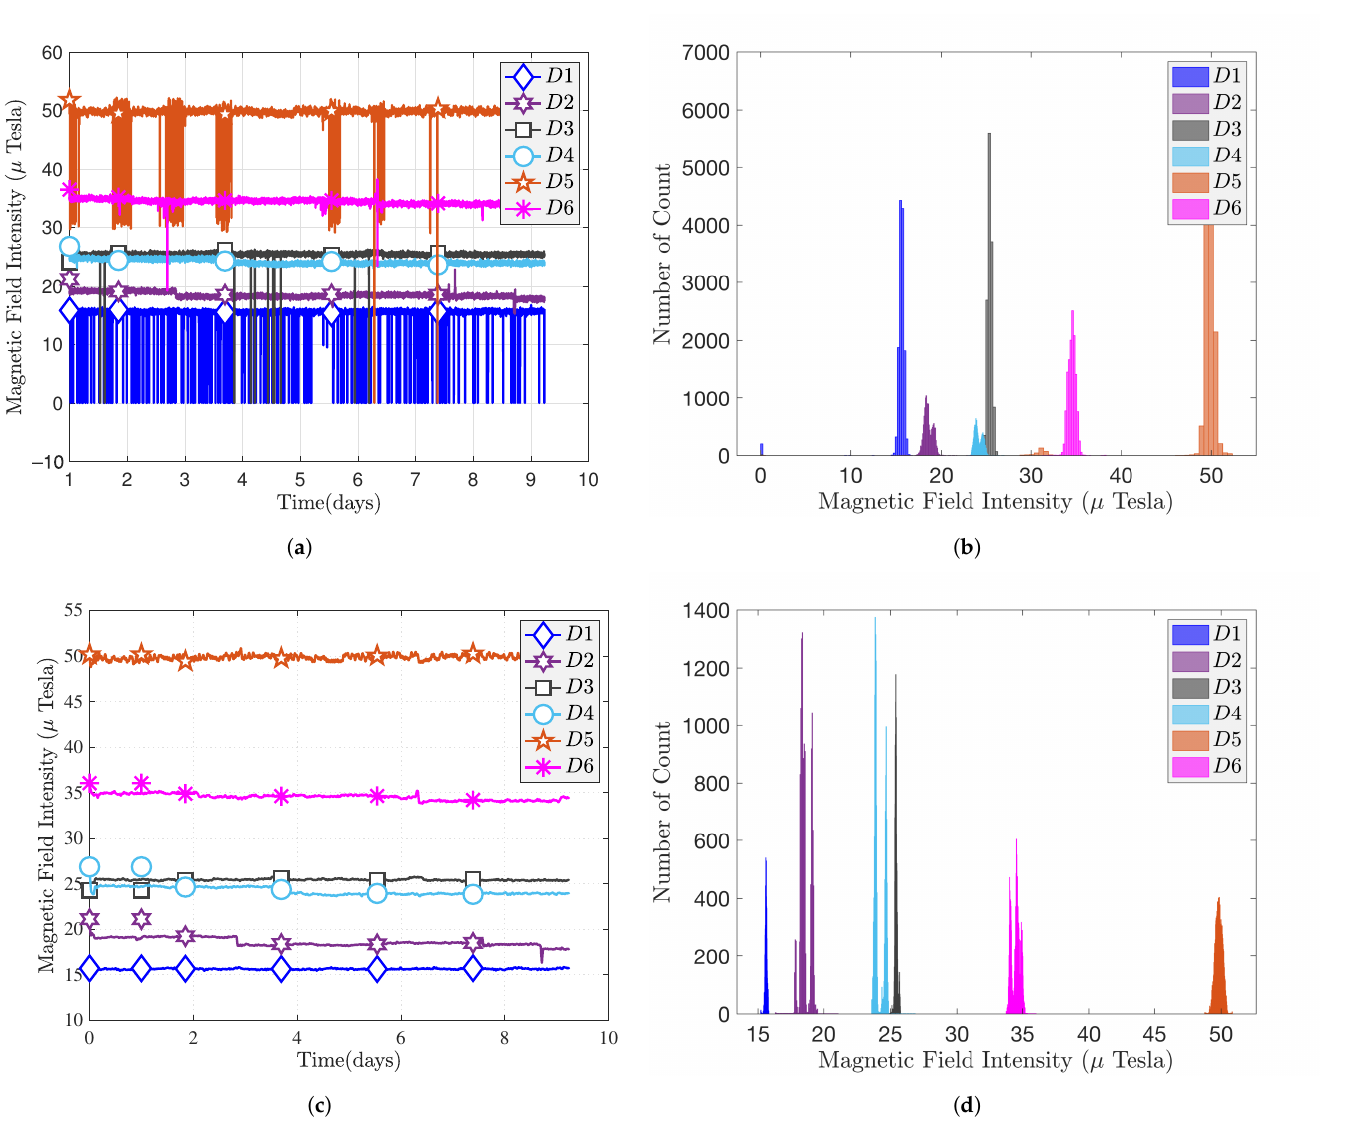
Figure 9. Nine-DoF LSM9DS1 sensor’s measurements: ( a ) original magnitude; ( b ) original magnitude histogram; ( c ) smoothing magnitude; ( d ) smoothing magnitude